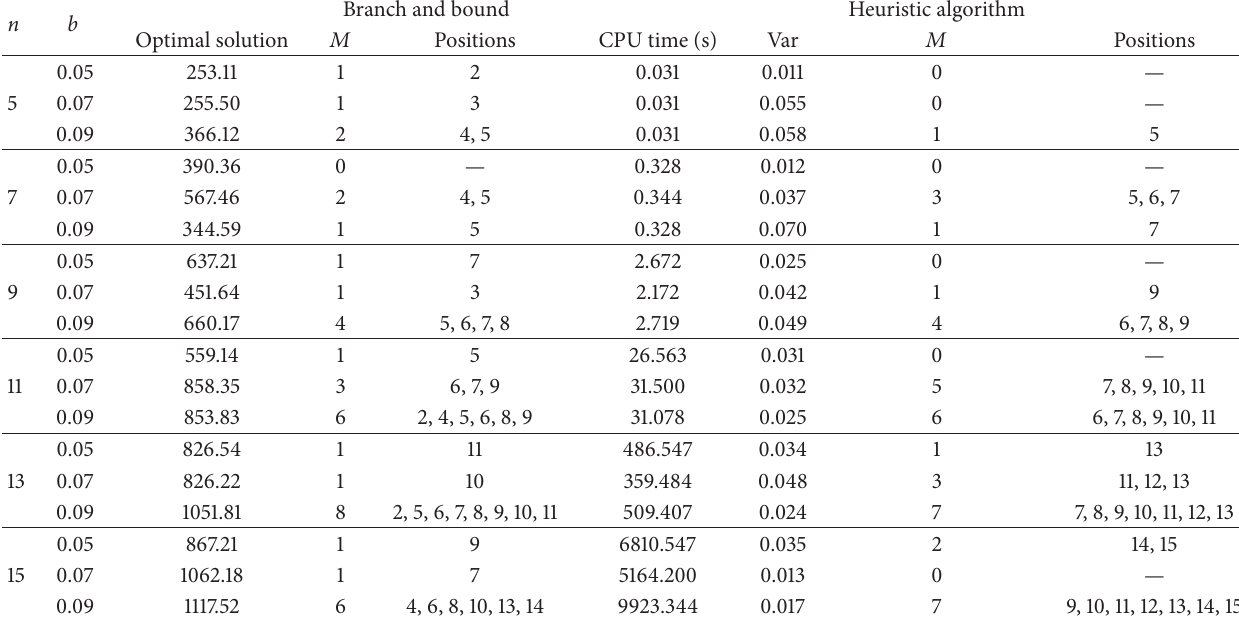
Table 2: Comparison of results from B & B; HA for 1|𝑝 𝑖𝑟 , mrm |𝐶 max